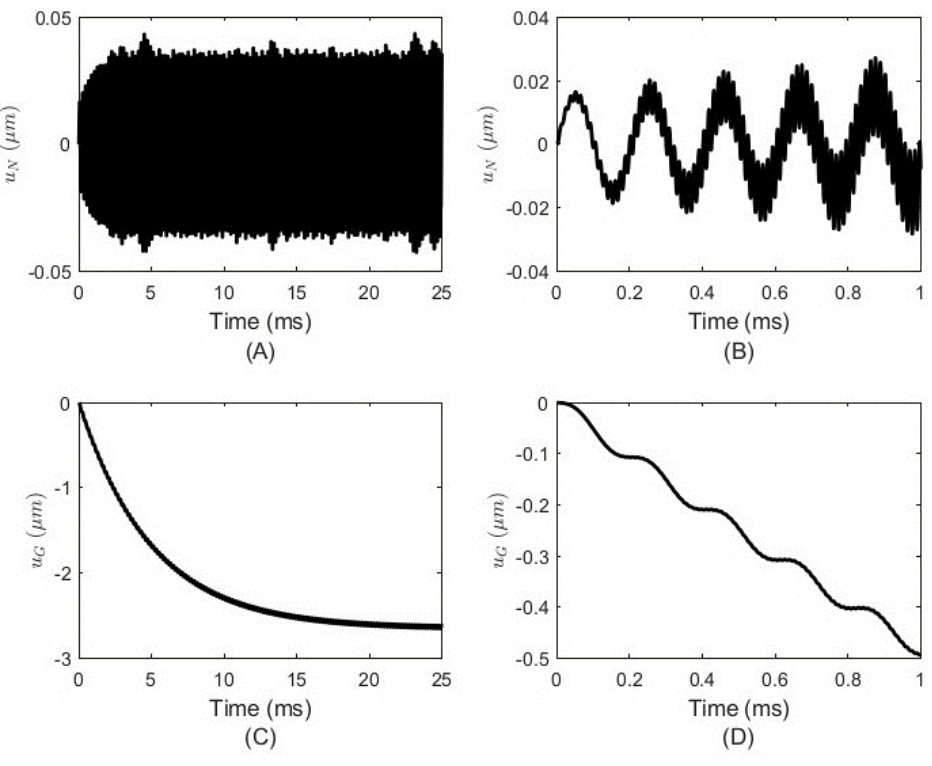
Figure 7. Results for the brain-on-a-chip with one glia’s endfoot in the case of non-decaying synthesis of NO: (A) neuronal displacement 𝒖 𝑵 , (B) a zoom-in of 𝒖 𝑵 , (C) displacement of the endfoot 𝒖 𝑮 , (D) a zoom-in of 𝒖 𝑮